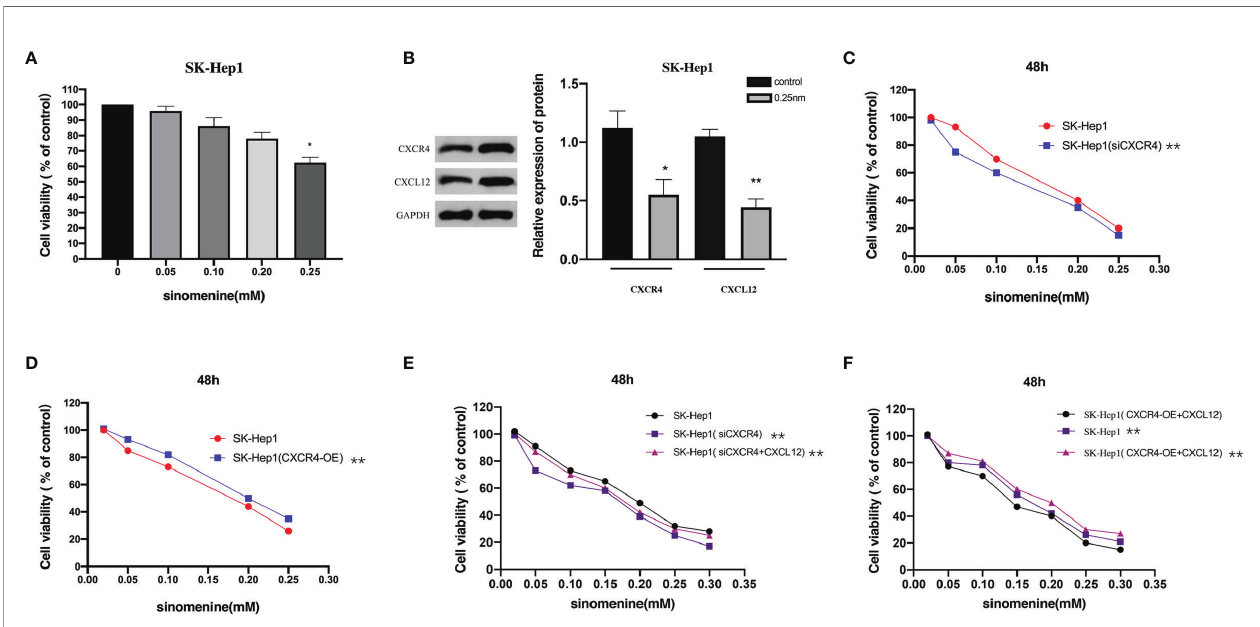
FIGURE 1 | The CXCL12-CXCR4 axis is involved in the role of sinomenine hydrochloride in the proliferative activity of hepatocellular carcinoma (HCC) cells. (A) 3- (4,5)-dimethylthiahiazo (-z-y1)-3,5-di- phenytetrazoliumromide (MTT) assay to assess the viability of SK-Hep1 cells exposed to diverse levels of sinomenine hydrochloride. (B) Western blot (WB) to detect the expression of CXCL12 and CXCR4 in SK-Hep1 cells. (C) Decrease of CXCR4 expression by siCXCR4 in SK- Hep1 cells, SK-Hep1 cellular activity was identi fi ed via CCK-8 analysis. (D) SK-Hep1 cellular activity was identi fi ed in SK-Hep1 cells by overexpressing CXCR4, Cell Counting Kit-8 (CCK-8) assay. (E, F) CCK-8 assay measures cell viability. *P < 0.05,